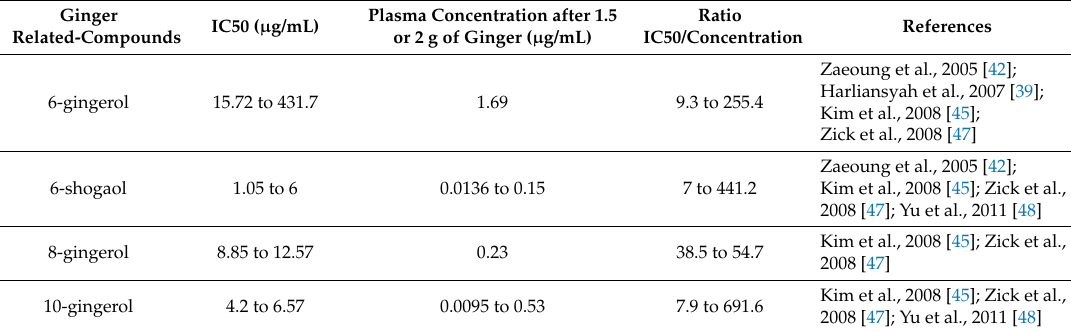
Table 6. IC50 values and plasma concentration